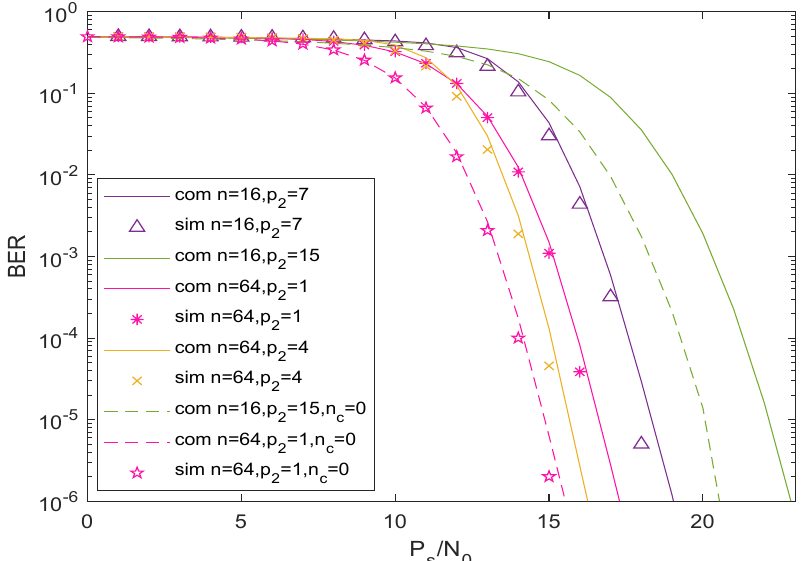
Figure 6. Simulations and analytical BER performance of GCI-DCSK SWIPT over AWGN channel with d tr = 1.